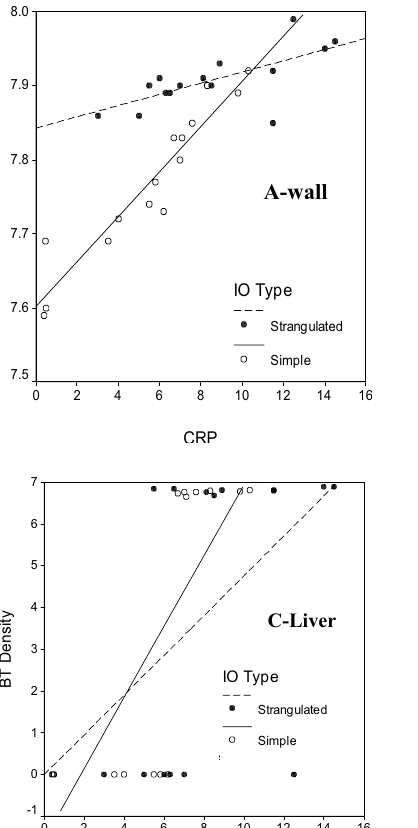
# Mann Whitney U test ## Chi-Square test.